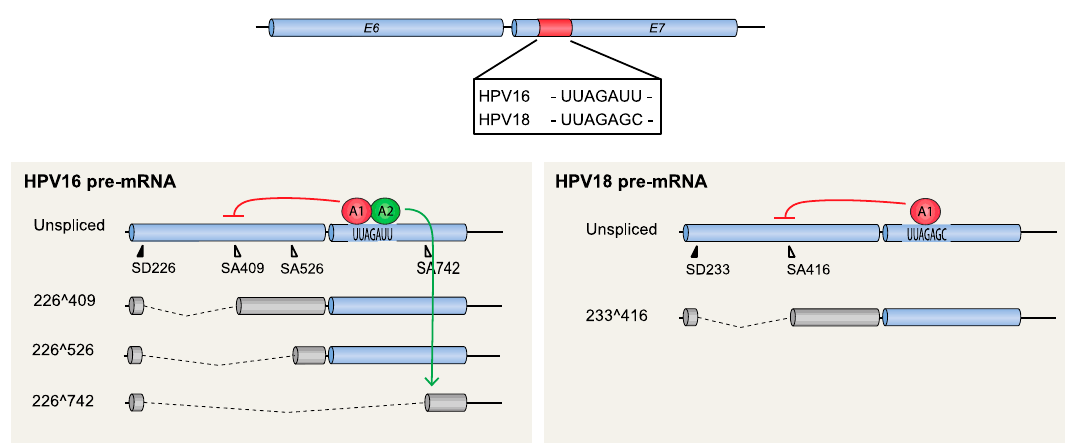
Figure 5. Control of HPV16 and HPV18 E6/E7 mRNA splicing by splicing silencers located in the E7-coding region. Schematic representation of the HPV E6- and E7-coding regions as blue cylinders. The location of a splicing silencer element in the E7-coding region of HPV16 or HPV18 is shown as a red cylinder. The sequence of each splicing silencer element is indicated. The HPV16 splicing silencer interacts with hnRNP A1 and hnRNP A2 to inhibit HPV16 3 ′ -splice site SA409. Inhibition of HPV16 SA409 by hnRNP A1 results in the production of unspliced E6-encoding mRNAs (red arrow), whereas inhibition of HPV16 SA409 by hnRNP A2 results in redirection of splicing to the downstream HPV16 3 ′ -splice site SA742 (green arrow). In HPV18, binding of hnRNP A1 to the splicing silencer results in inhibition of SA416 and production of unspliced E6-encoding mRNAs (red arrow).